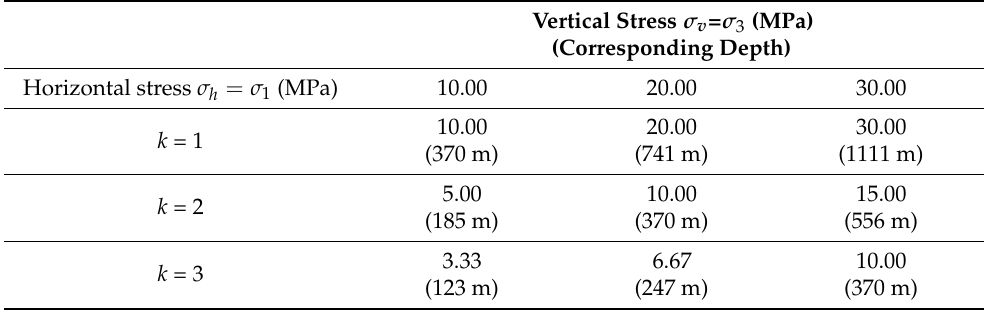
Table 3. In situ stresses and the corresponding